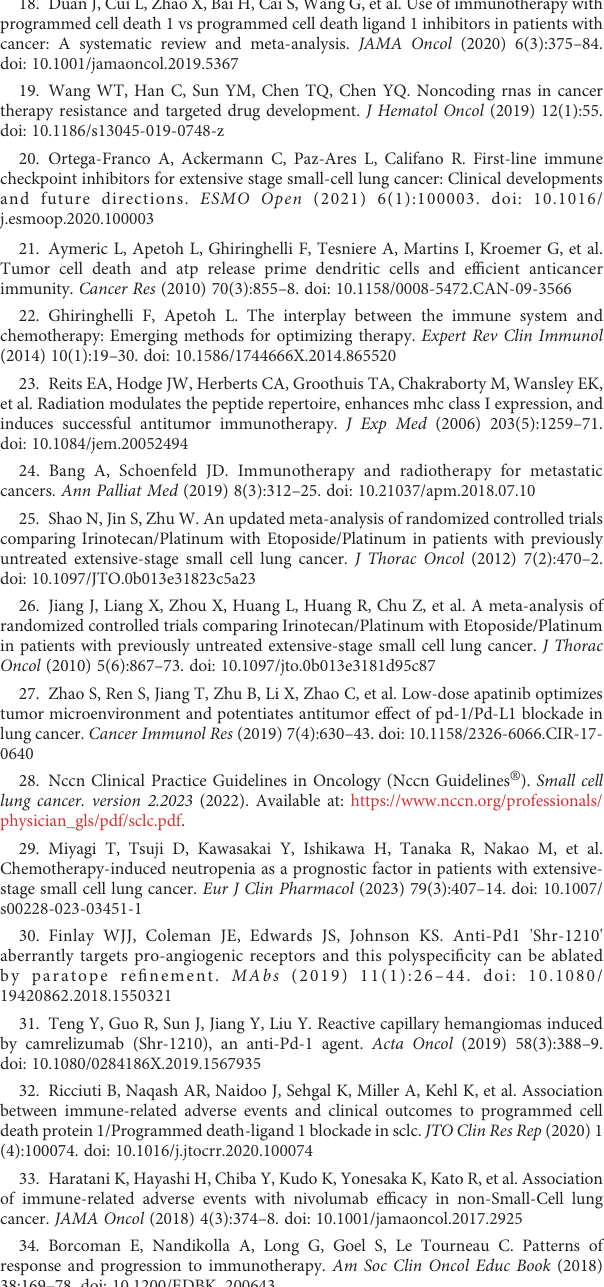
SUPPLEMENTARY FIGURE 1 Baseline characteristics of patients by treatment pattern. SUPPLEMENTARY FIGURE 2 Forest plot of subgroup analysis of progression-free